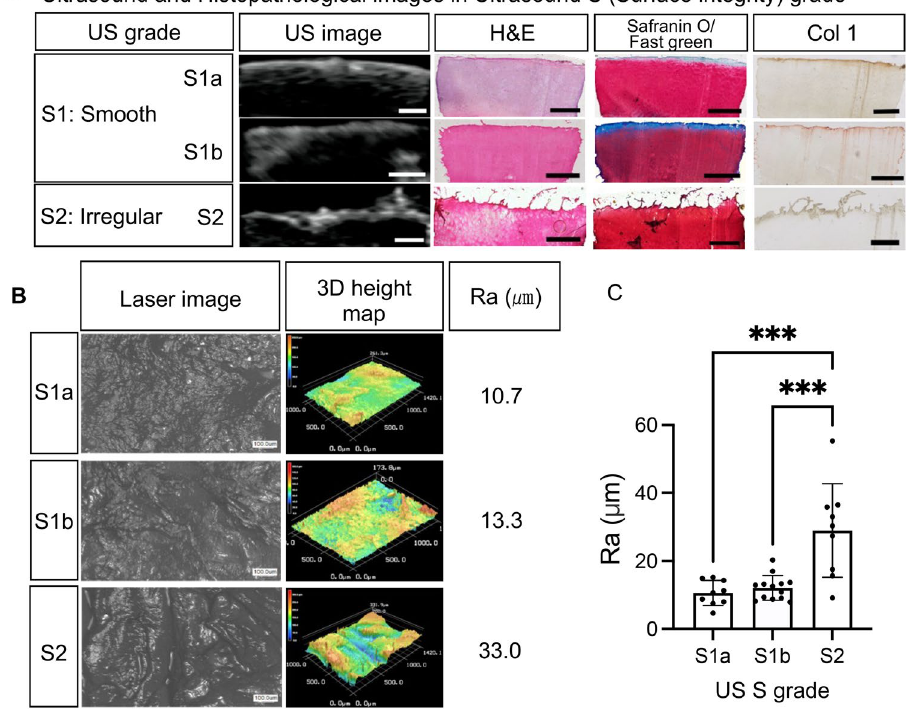
Figure 1. Ultrasound S (Surface integrity) grade and the surface roughness of articular cartilage. ( A ) Ultrasound images of typical cases. Comparing with S1, the cartilage surface integrity was lost in S2. Within S1, the superficial zones were basically intact, but in S1b there were more deep fibrillations than that of S1a. Scale bars: 1 mm. ( B ) Typical examples of surface roughness analysis. Scale bars: 100 μm. ( C ) Mean Ra; bars are show the mean ± SD. *** p <